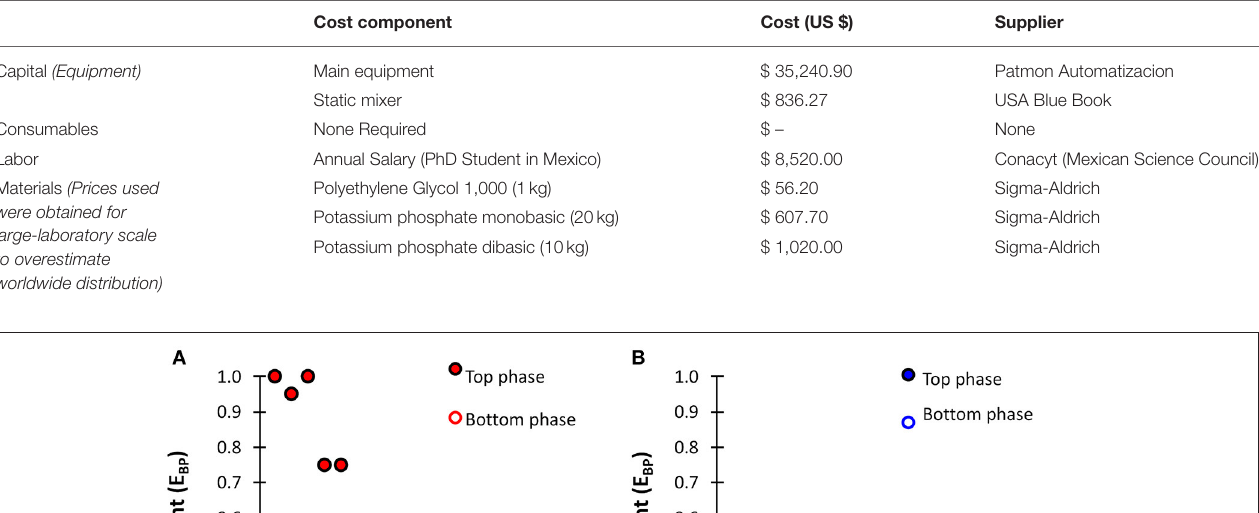
TABLE 3 | Dataset used for model construction in Biosolve Process.